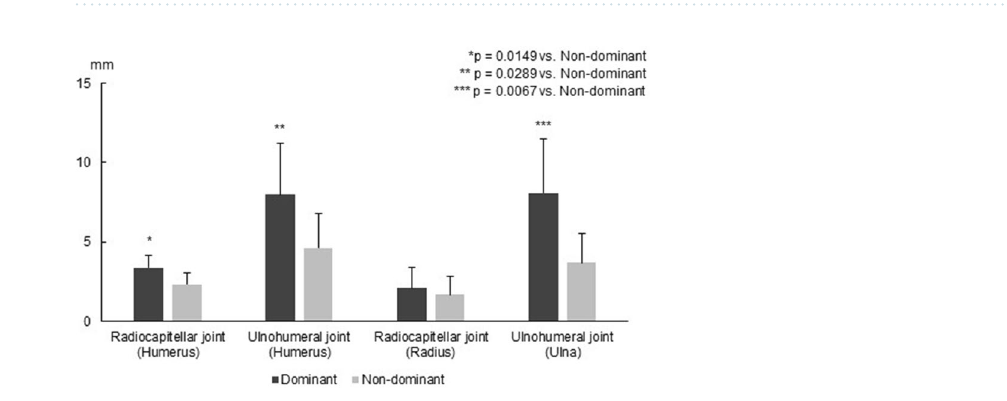
Figure 1. Elbow joint contact area and the centroid of each area. ( A ) The humeral contact area of the radiocapitellar joint. The joint space is wide (blue) and narrow (red). The centroid of each joint contact area is denoted by the black dot. ( B ) The humeral contact area of the ulnohumeral joint. ( C ) The radial contact area of the radiocapitellar joint. ( D ) The ulnar contact area of the ulnohumeral joint.